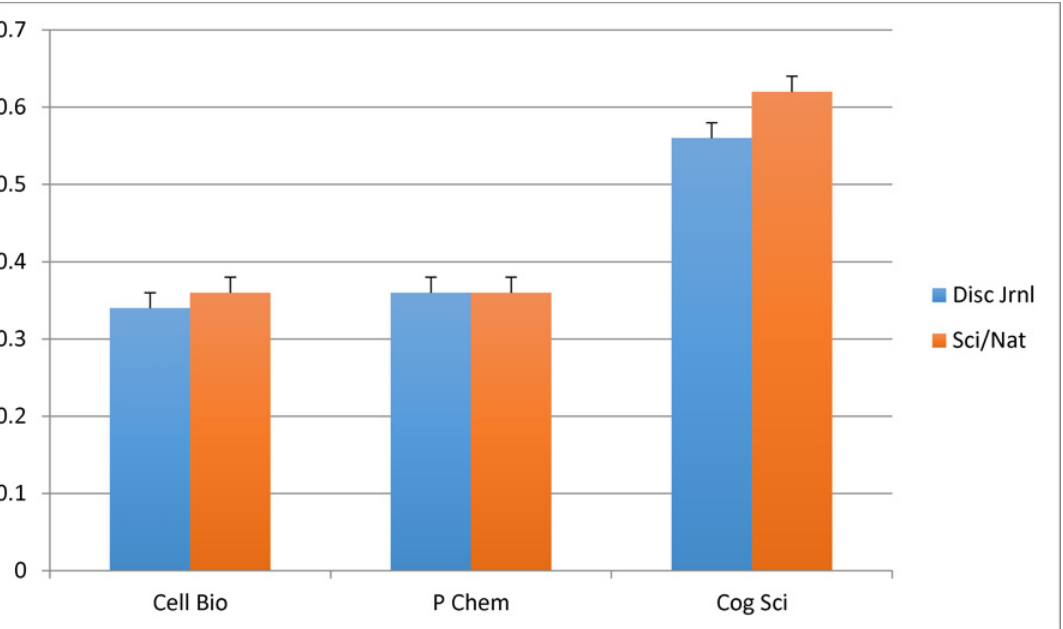
Fig 2. Mean Diffusion Scores of Articles Appearing in Disciplinary Journals Compared to those in Nature/Science , by Field. Cell Bio = Cell Biology, P Chem = Physical Chemistry, Cog Sci = Cognitive Science, Disc Jrnl = Disciplinary journal, Sci/Nat = Science and Nature .